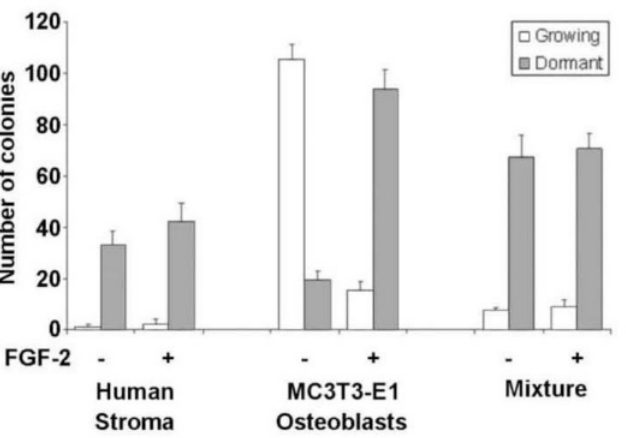
Figure 2. Mixing mouse MC3T3 ÷ E1 osteoblasts with human stroma at a ratio of 1:10 increases the capacity to support dormant MCF ÷ 7 cell clones almost two-fold. FGF ÷ 2 produced by stoma is sufficient to support dormancy [79], with exogenous FGF ÷ 2 having no additional effect on stroma or mixing experiments ( p > 0.05). However, exogenous FGF ÷ 2 is necessary for dormancy on MC3T3 ÷ E1 monolayers, suggesting they do not produce and export FGF-2. The dormancy support efficiency on MC3T3 ÷ E1 cells is greater than that of stroma by more than two-fold ( p < 0.05). Error bars ±